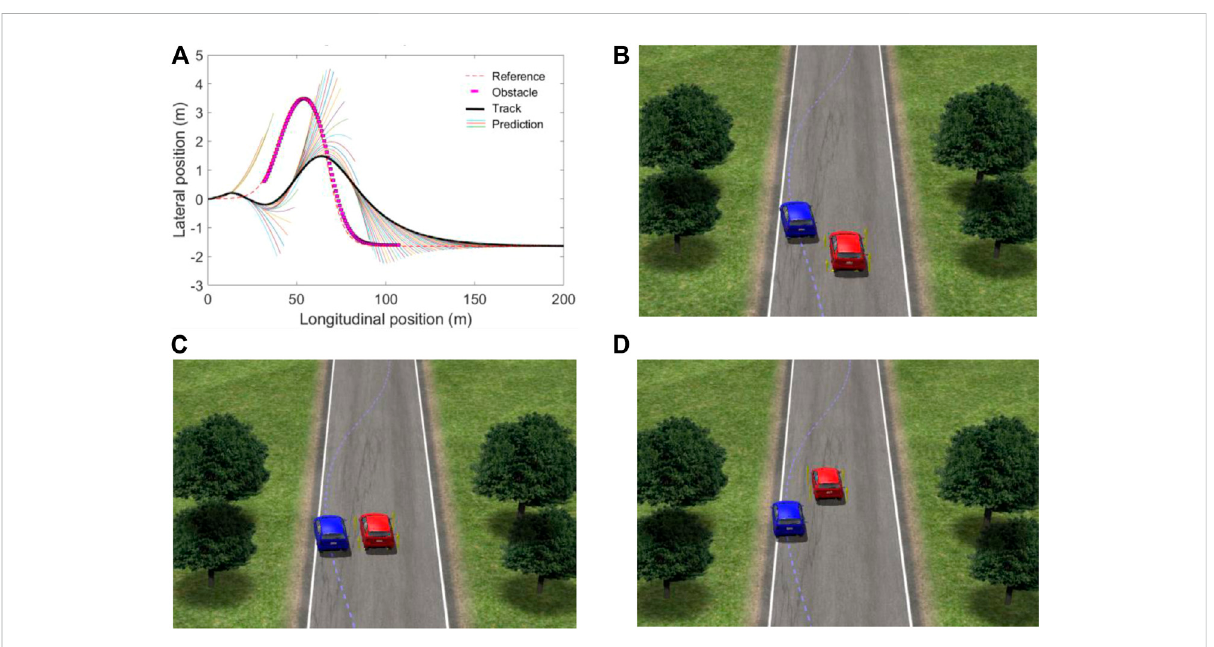
FIGURE 5 Obstacle avoidance trajectory and obstacle avoidance model at 72 km/h. (A) obstacle avoidance trajectory; (B) model before obstacle avoidance; (C) model during obstacle avoidance; (D) model after obstacle